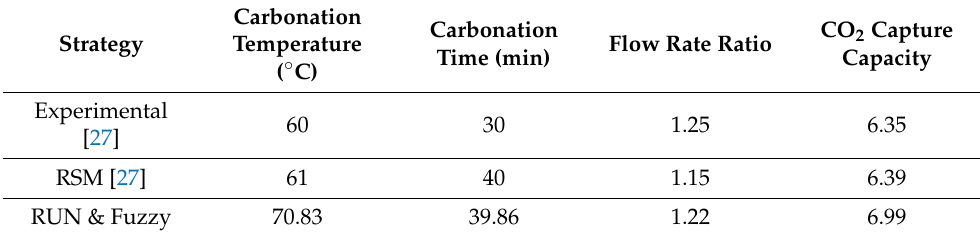
Table 3. Optimal values of parameters using different